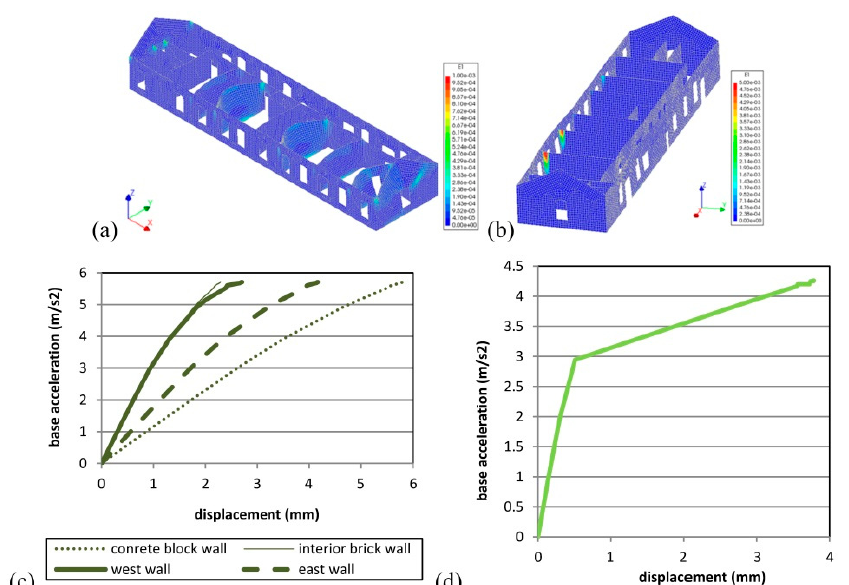
Figure 12. Nonlinear static analysis of the Matsumoto storehouse: principal positive strain distri- bution contours close to the failure of the structure in the x- direction ( a ) and in the y- direction ( b ), relations between base acceleration and displacement in the x- direction ( c ) and in the y- direction ( d ).